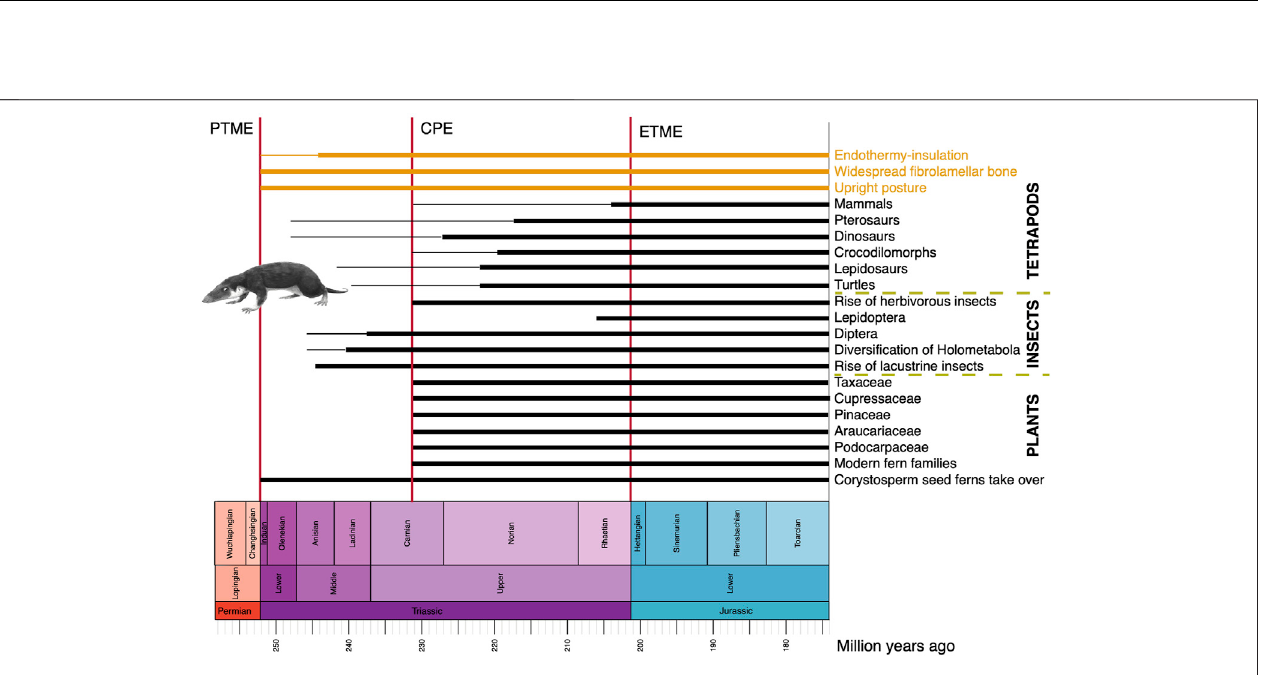
Frontiers in Earth Science |